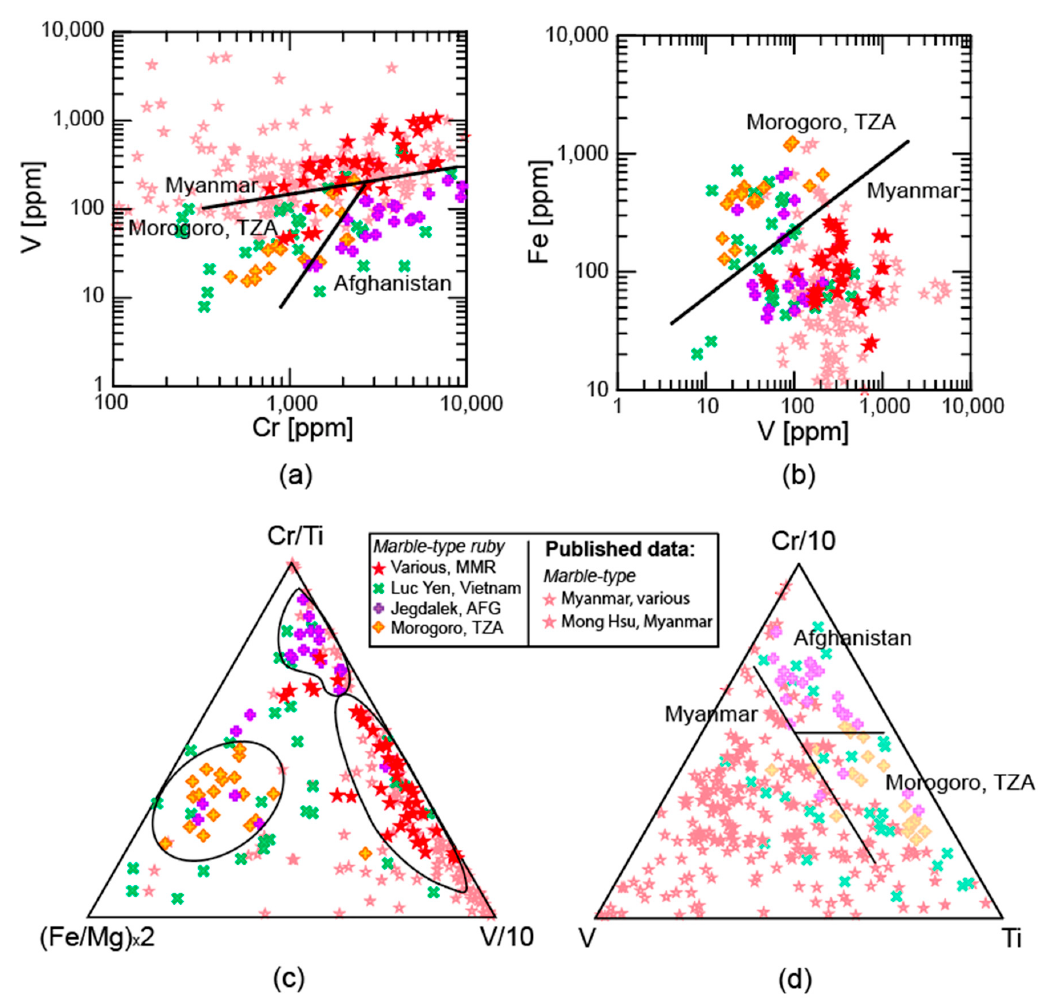
Figure 13. ( a ) Binary plot of V (ppm) versus Cr (ppm), ( b ) binary plot of Fe (ppm) versus V (ppm), ( c ) ternary diagram of Fe/Mg × 2-Cr/Ti-V/10, and ( d ) ternary diagram of V-Cr/10-Ti for marble-type rubies analyzed using LA-ICP-MS in this study. Fields are drawn by eye. Additional data from [33,62].